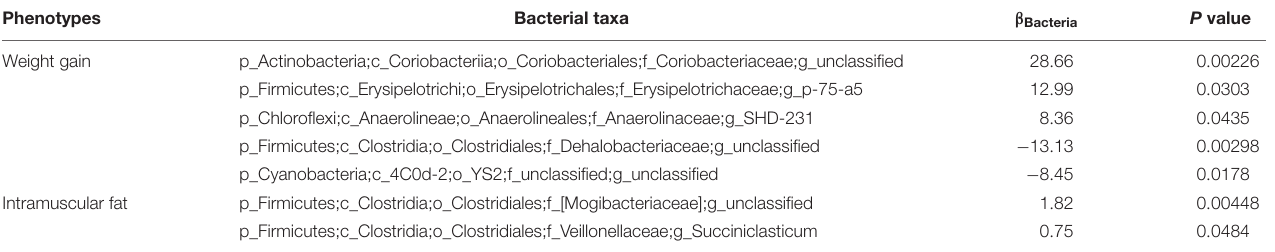
TABLE 1 | The association between the log transformed relative abundance of bacteria and animal